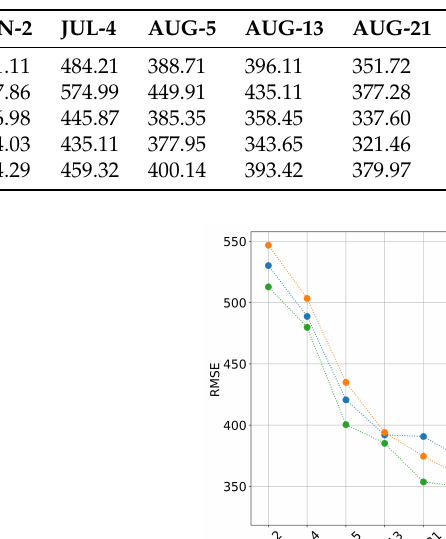
Table 5. Model performance of the CNN-LSTM measured in RMSE, 2011–2015.